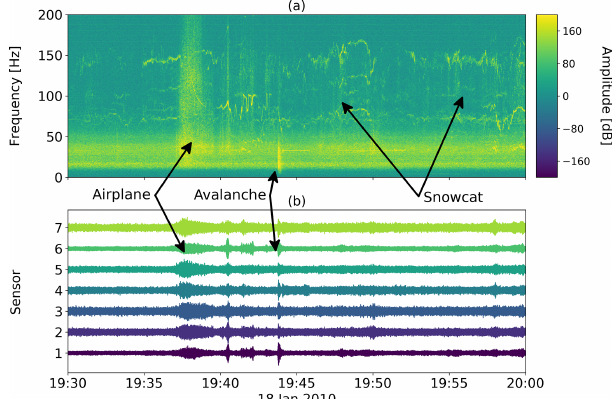
Figure 1. (a) Spectrogram of an unfiltered 30min time series. (b) Corresponding time series. An airplane and an avalanche are visible. Furthermore, noise produced by a snowcat can be seen in the second half of the time series.